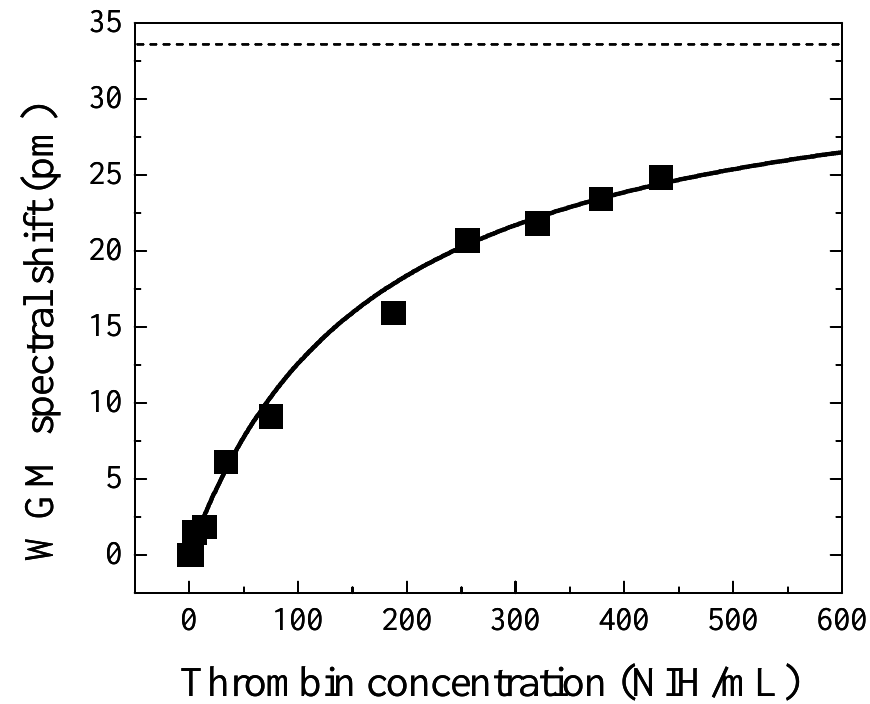
Figure 7. WGM spectral shift as a function of thrombin concentration obtained from Figure 6. Solid curve is the calculation from Eq. (3) with K Unit/mL and δλ = 34 pm. Dashed line shows the WGM shift for the maximal max thrombin binding ( δλ max